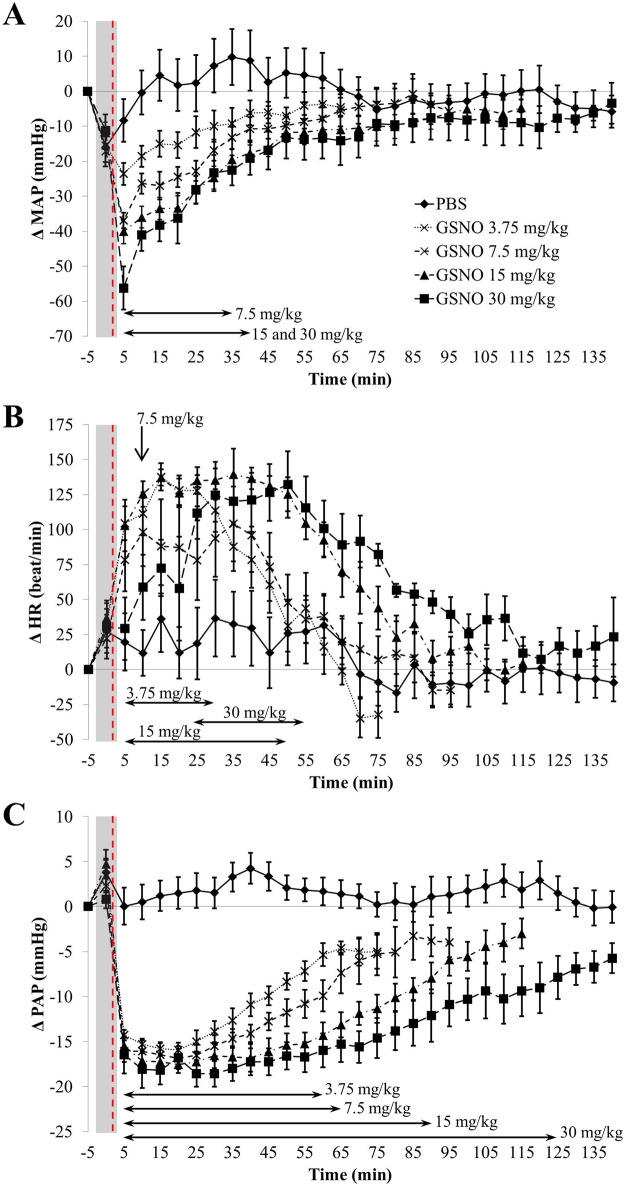
Impact of free GSNO on MAP, (panel A), HR, (panel B) and PAP (panel C).pinteraction, pdose and ptime < 10−4 for all parameters (two-way ANOVA; post-hoc Bonferroni test). Each animal (n = 7) received all the treatments. Arrows indicate for each dose the time span where significant differences vs. PBS were observed. Grey boxes represent the duration of anesthesia and red vertical dashed lines the time of injection.